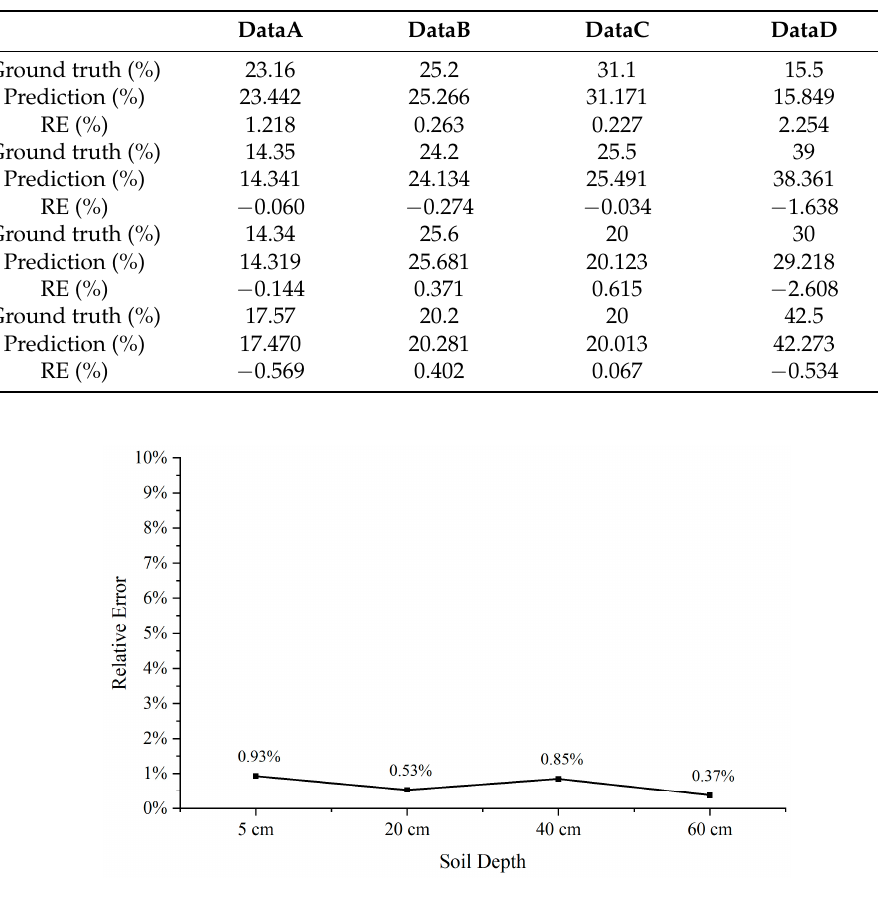
Figure 7. Average absolute value of predicted value error.